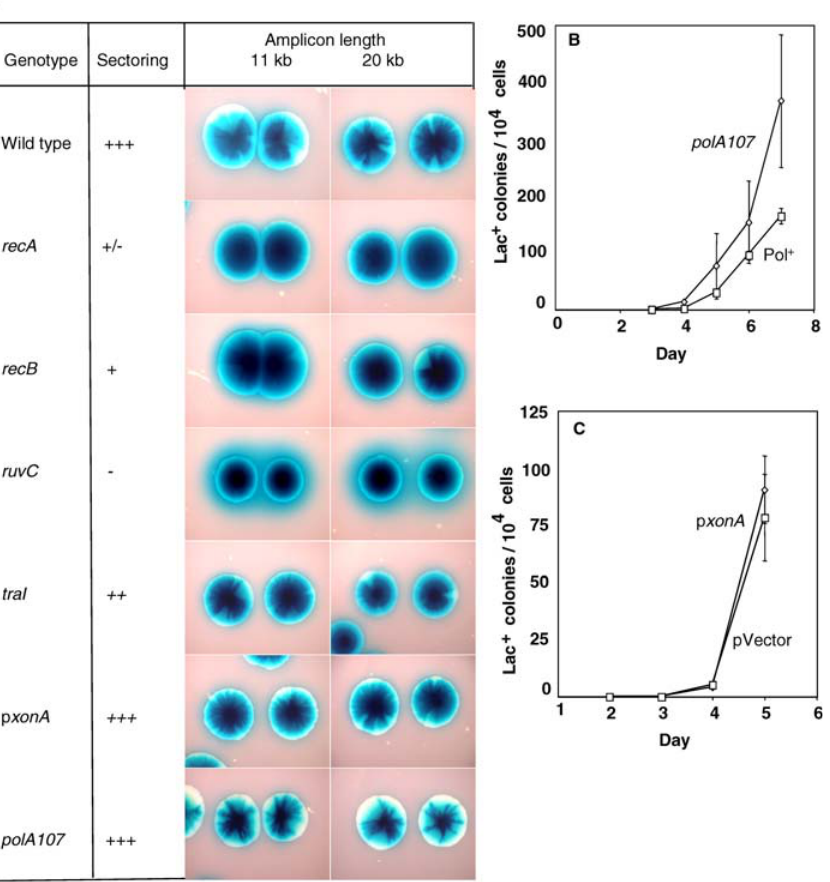
Figure 7. Reduced Amplification in a polA107 Mutant and in Cells Overexpressing xonA Is Not Caused by an Inability to Expand from a Duplication to Give Lac þ Colonies (A) Colony-sectoring phenotypes of amplified DNA arrays in relevant genetic backgrounds: a qualitative measure of homologous recombination in repeated sequences. Phenotypes were scored by visual inspection of sectoring in 3-d-old colonies of these strains grown on M9 glucose minimal medium containing 60 l g/ ml X-gal. Use of minimal medium is preferable to rich medium because the former avoids the presence of sectors caused by loss of the F 9 (F (cid:1) derivatives of these strains are proline requiring). Before plating, the cells were grown in lactose minimal medium, selecting for maintenance of the amplification. Sectoring was scored on a five-point scale ( þþþ , þþ , þ , þ / (cid:1) , and (cid:1) ) based on the intensity of sectoring, and the occurrence of non-sectored colonies among more than 100 colonies derived from single cells. This provides a measure of recombination that leads to loss of amplification [16]. The 11-kb and 20-kb amplifications used are from independent, representative strains PJH18 and PJH51 carrying lac amplifications with 10.88-kb and 20.33-kb repeat unit lengths, respectively. Strains used, containing amplicons from PJH18 and PJH51 respectively, were: Wild type; PJH428 and PJH430, recA; PJH433 and PJH435, recB; PJH438 and PJH440, ruvC; PJH443 and PJH445, traI; PJH453 and PJH455, p xonA; PJH518 and 519, polA107; PJH520 and PJH521. (B and C) Quantitative measure of expansion from a duplication to amplification. Cells of the genotypes shown carrying a 25.5-kb duplication of the lac region were plated under conditions of an adaptive mutation